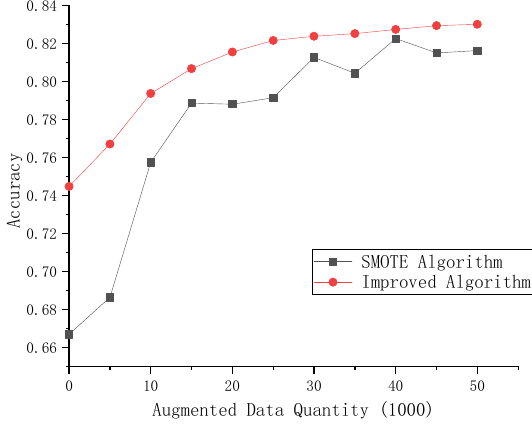
Fig. 5 Contrast Between Traditional SMOTE Algorithm and the Improved SMOTE Algorithm